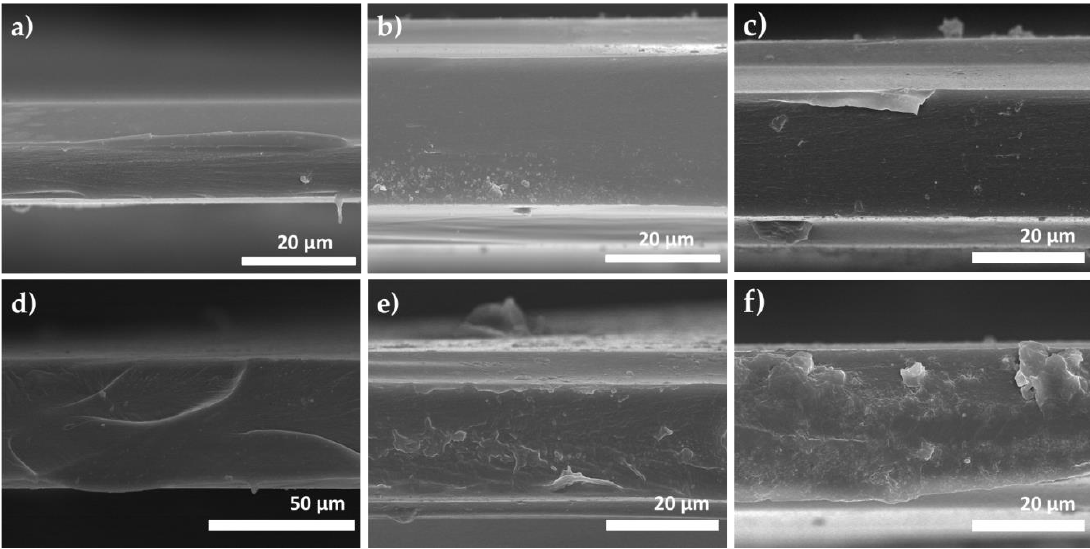
Figure 6. Cross-section SEM images of ( a ) neat 6FDA-ODA and its crosslinked membranes with ( b ) m -xylylene diamine and ( c ) n -ethylamine, ( d ) neat 6FDA-ODA:DABA (8:2) and its crosslinked membrane with ( e ) ethylene glycol monosalicylate and ( f ) iron (III) acetylacetonate.